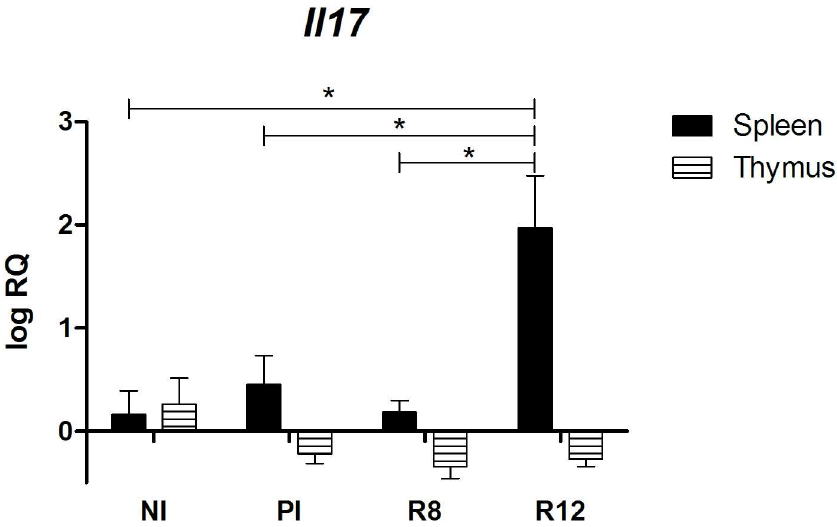
Fig 6. Effect of Fasciola hepatica reinfection on the Il17 expression from the spleen and thymus. Group NI: non-infectedcontrols; Group PI: rats received a singleinfection dose; Group R8: infected and reinfected rats at 8 weeks after primary infection; Group R12: infected and reinfected rats at 12 weeks after primary infection. Bars represent mean ± SE values. * Statistically significantdifferences (P < 0.05,Mann- Whitney non-parametric